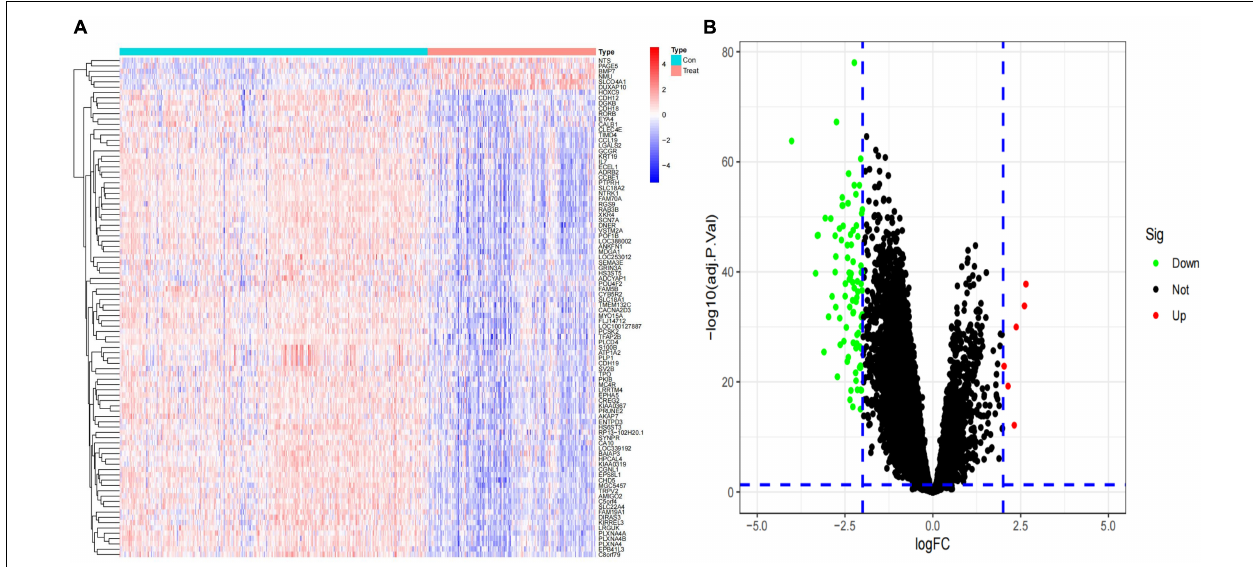
FIGURE 1 | Identification of differentially expressed genes (DEGs) in the training dataset. (A) Heat map of the DEGs; (B) volcano map of the